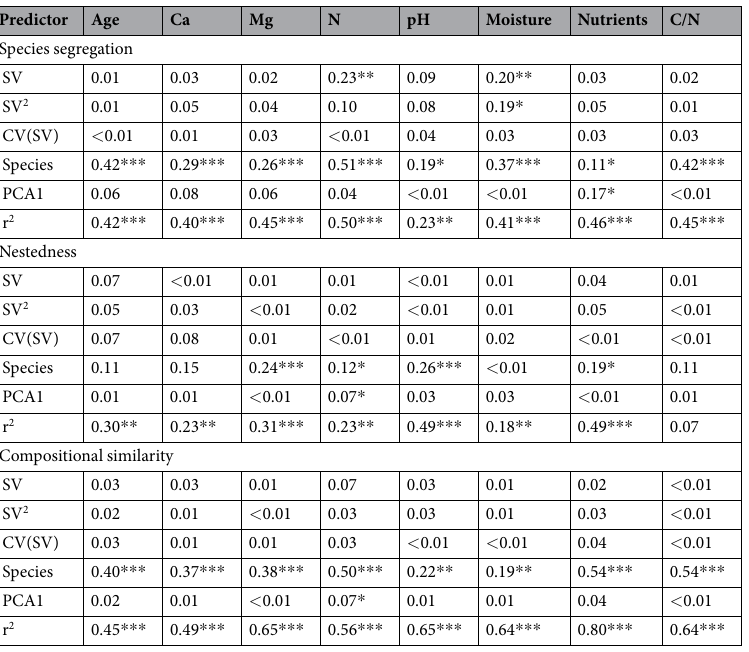
Table 2. Generalized linear modelling (partial η 2 values) points to soil nitrogen content, pH and moisture to directly influence the pattern of understorey plant segregation (SES C-score). Degrees of nestedness (SES NODF) and species composition (SES Soerensen index) were mainly influenced by variation in species richness. Note that SES C-score, SES NODF, and SES Soerensen index served always as dependent variables. SV, squared SV, and the coefficient of variation CV(SV) refer to the respective soil variables listed in the columns. ln-transformed species richness and the dominant spatial eigenvector (PCA1) served as additional covariates. Nutrients, pH, and moisture refer to Ellenberg scores. Parametric Bonferroni corrected (40 single tests) significance levels: * P(F) < 0.05, ** P(F) < 0.01, *** P(F) <